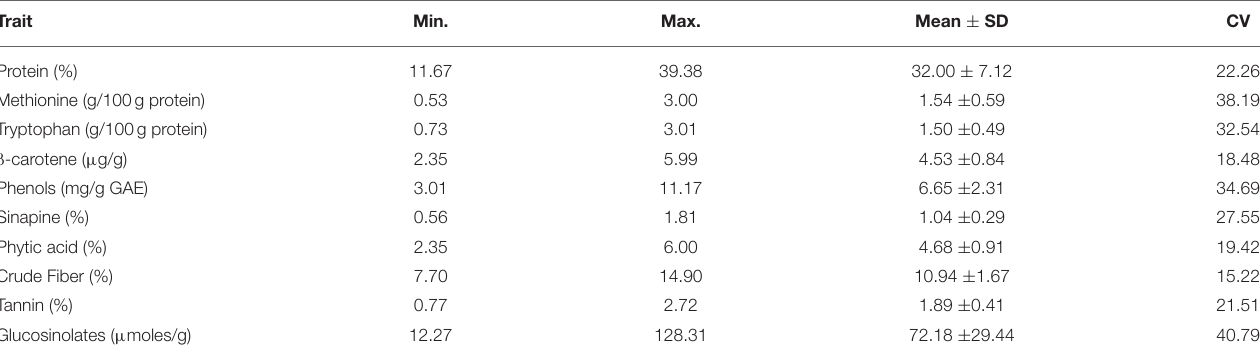
TABLE 1 | Phenotypic variation for ten seed meal quality traits in B. napus diversity panel.